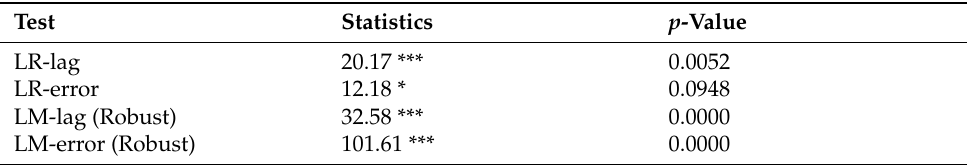
Table 3. Results of spatial panel econometric model